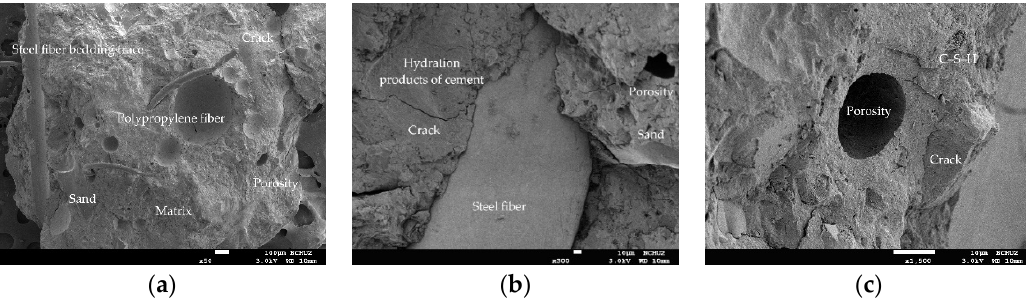
Figure 14. SEM observations of the UHPC sample at room temperature: ( a ) 50× magnification, ( b ) 300× magnification, and ( c ) 1500× magnification.